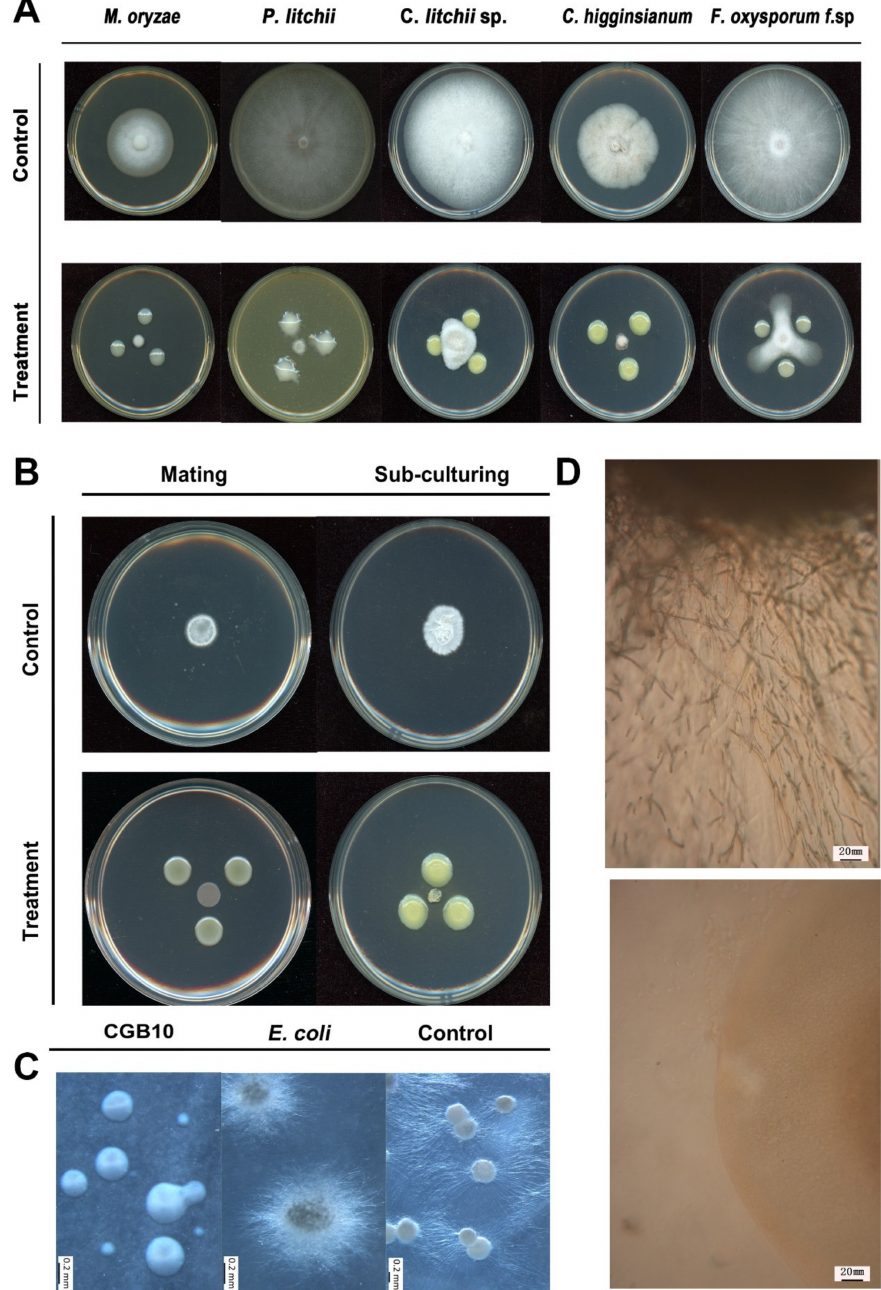
Figure 2. A sugarcane endophytes bacterium CGB10 could suppress the filamentous growth of multiple pathogenic fungi. ( A ) Antagonistic inoculation of CGB10 with fungal colonies on the solid medium (detailed in Materials and Methods), incubated at 28 ◦ C for 7 d, before photographing. ( B ) Antagonistic inoculation of CGB10 with filamentous colonies of S. scitamineum , by mixing the sporidia of opposite mating types to induce sexual mating, or by subculturing the mycelial colony, on the solid PDA medium, incubated at 28 ◦ C for 7 d, before photographing. ( C ) CGB10 suppressed promycelium formation from S. scitamineum teliospores. Liquid cultured CGB10 (OD = 1.0) was applied to the PDA plate covered with a layer of cellophane, which was removed after culturing at 28 ◦ C for 24 h, and S. scitamineum teliospores were streaked on this pre-treated PDA medium to initiate germination. Scale bar = 0.2 mm. ( D ) Microscopic observation of the edge of teliospore colony with or without CGB10 pre-treatment. Scale bar = 20